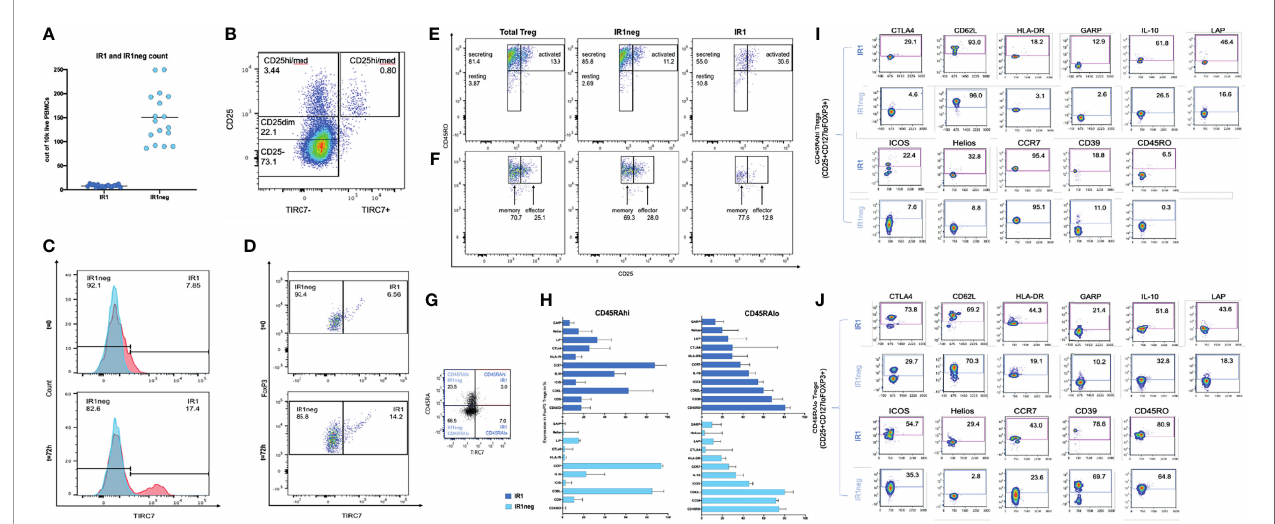
FIGURE 1 | (A) IR1 (TIRC7+) and IR1 neg Tregs (TIRC7-) frequencies as counts per 10,000 freshly isolated PBMC in peripheral blood from 22 healthy subjects. (B) Differentiation of CD25+ population shows distribution of CD4+ CD25+ TIRC7+ cells, which are mainly localized between CD25med/hi. Cells were pre-gated on CD4. (C) Two overlaid histograms (blue FMO control, red TIRC7 panel) show extracellular TIRC7 expression on Tregs from healthy donors, directly after isolation (T=0h) (upper panel) and after 72h IL-2 stimulation (lower panel). The x-axis shows TIRC7 expression. (Supplemental data for gating: 1.1 for t0, 1.2 for t72h). Post expansion (lower panel) the proportion of IR1cells is higher than pre-expansion (upper panel). (D) The x-axis shows TIRC7 expression. The Y-axis shows FOXP3 expression levels. At t0 (upper panel) IR1 cells express FOXP3. After 72 hours (lower panel) of IL-2 induction the proportion of FOXP3+IR1 cells is further increased. Cells were pre-gated on CD4, CD25, CD127lo and FOXP3. ( Supplementary Figures 1.2 , 1.3 ). (E) Treg subpopulations (IR1neg and IR1) are mapped as secreting (CD45RO+, CD25dim/med), resting (CD45RO-, CD25dim/med) and activated (CD45RO+, CD25bright) subsets of Treg at t=72h